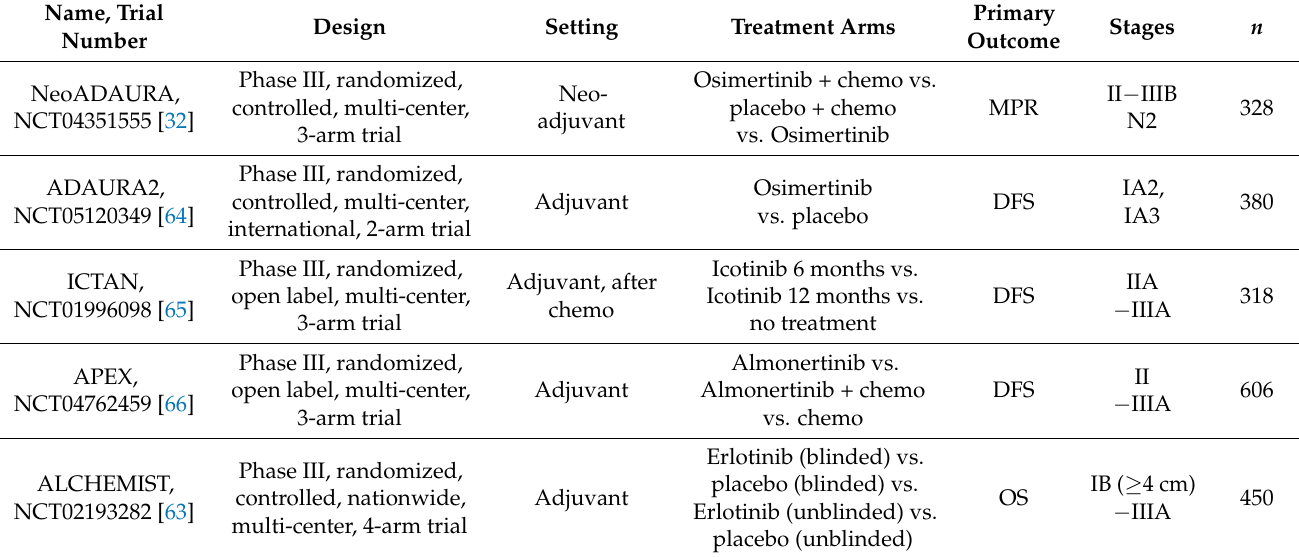
Table 4. List of ongoing comparative trials. All these data are available on https://www.clinicaltrials. gov/ (accessed on 30 March